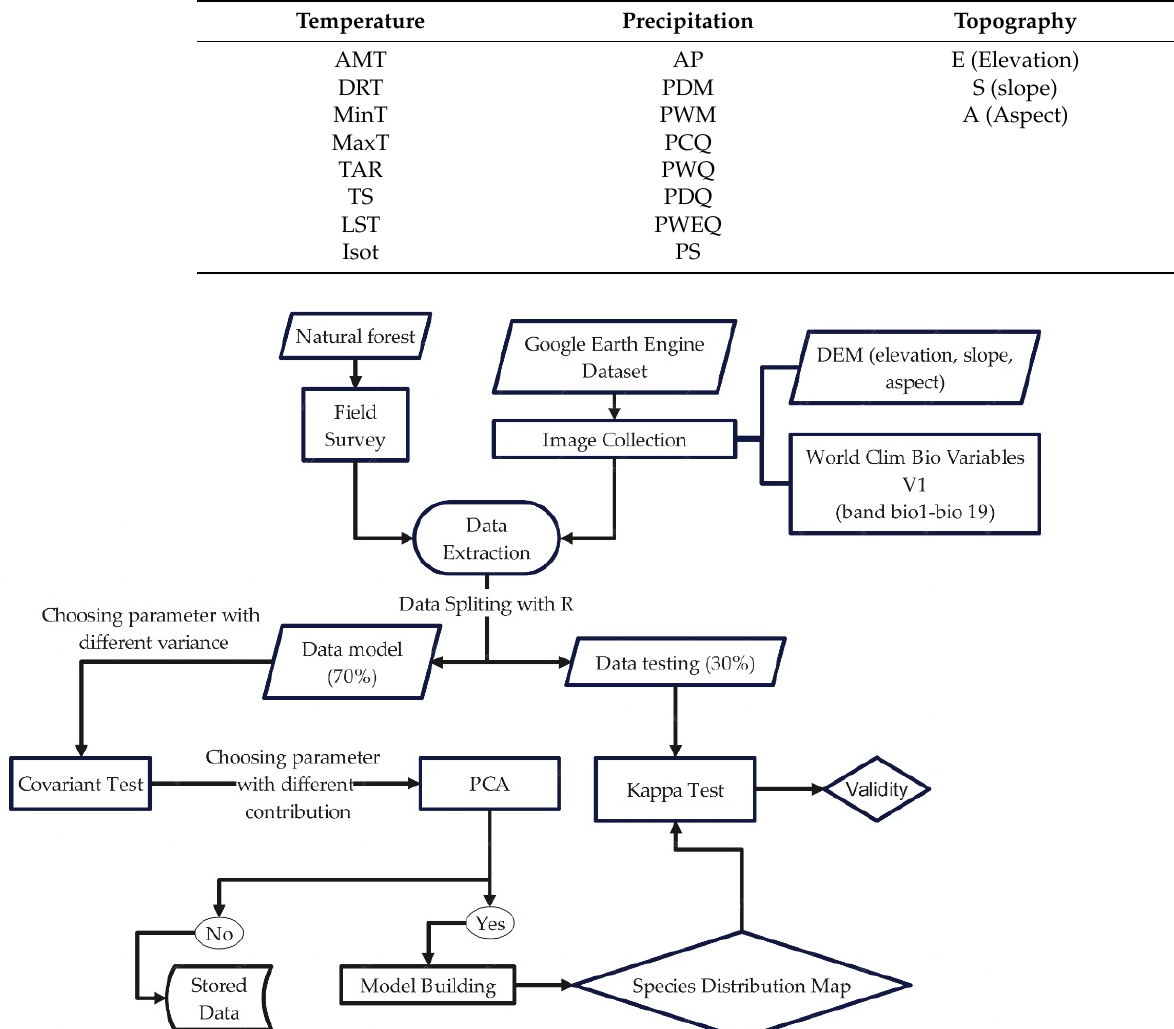
Table 1. Parameters analyzed in each data category.